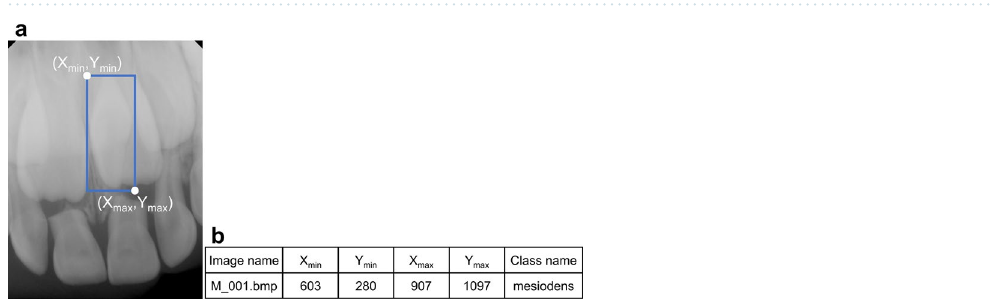
Figure 4. Example of an annotated periapical radiograph with a blue rectangular box ( a ) and extracted annotation information ( b ). The annotation information was composed of the upper left (X min , Y min ), the lower right (X max , Y max ), and the class name (“mesiodens”).